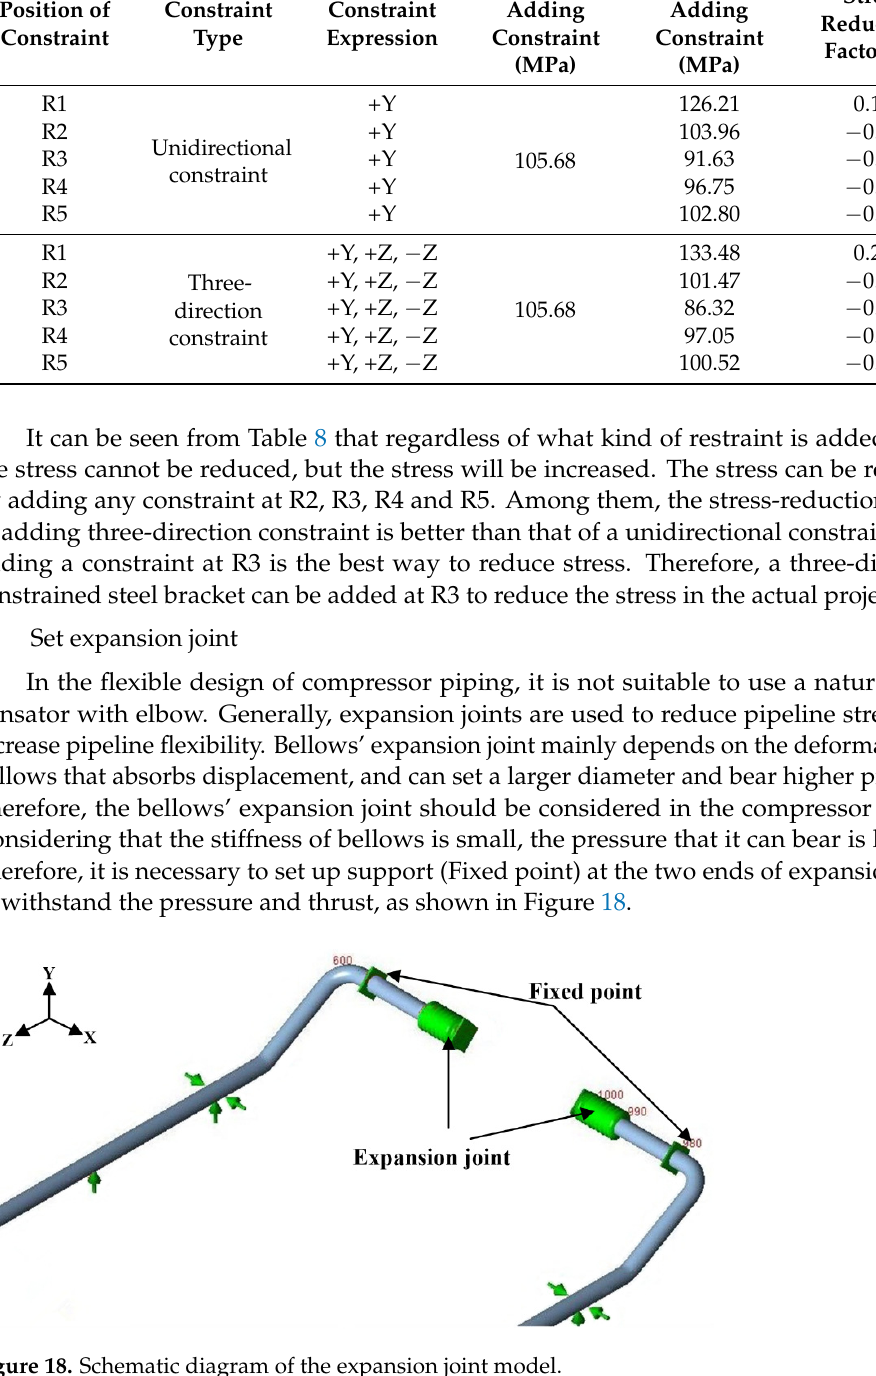
Table 8. Pipe stress after adding constraints.